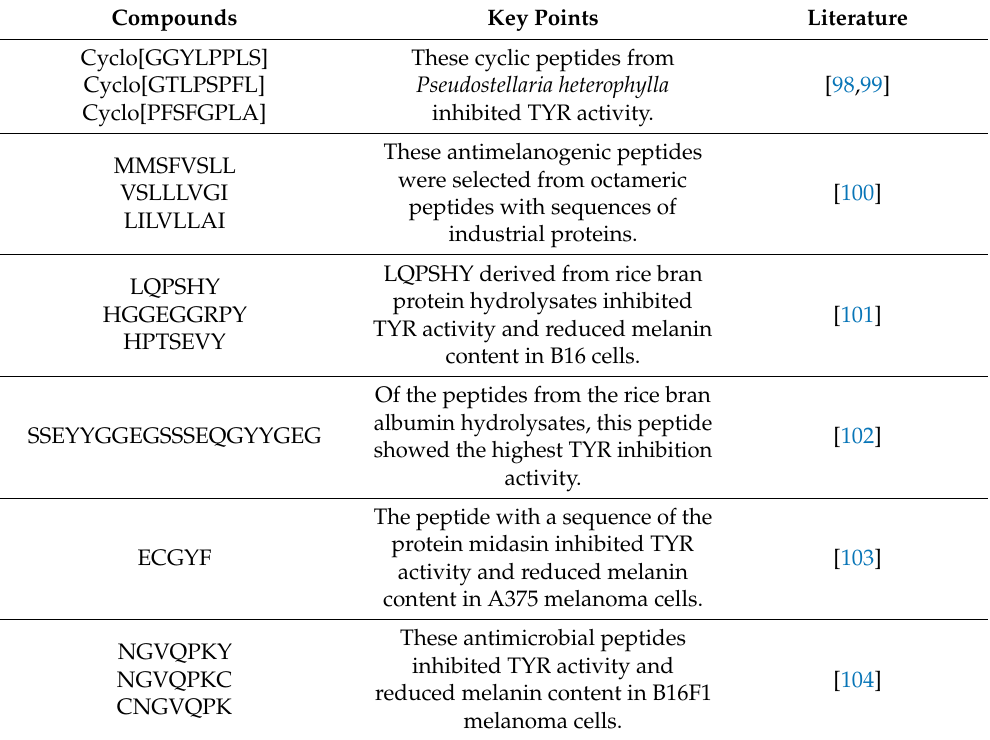
Table 3. TYR inhibitory peptides derived from natural protein sequences. Compounds Key Points